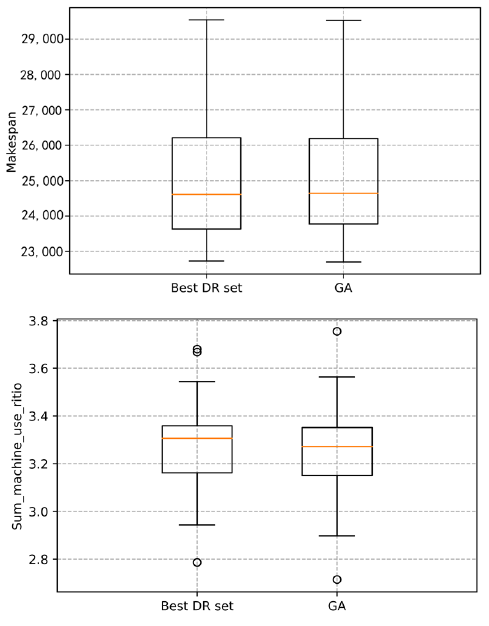
Figure 13. High job heterogeneity and a low manufacturing system load rate.